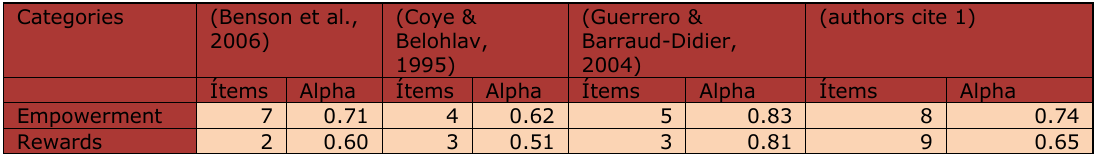
Tabla 6. Scale validation of type A